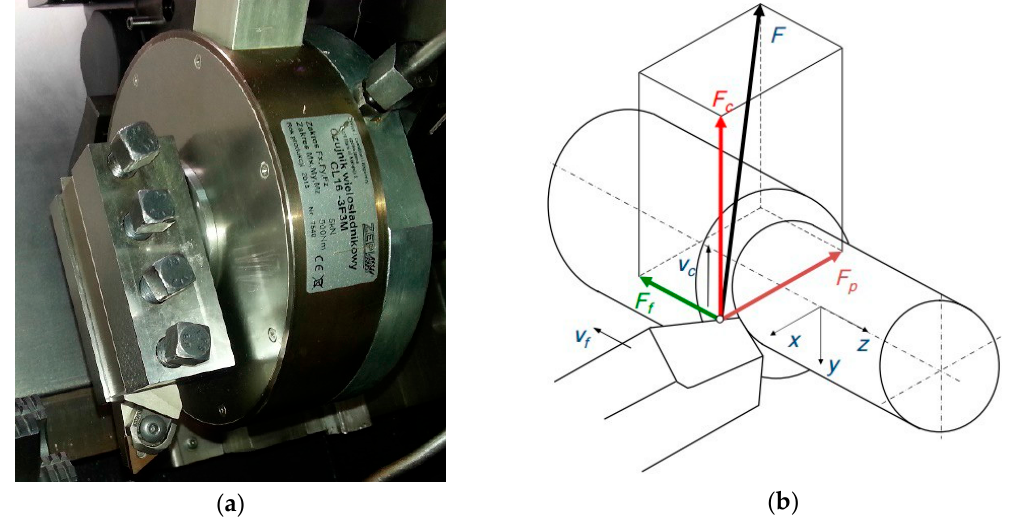
Figure 1. CL16-3F3M device: ( a ) The overall view; ( b ) scheme of the measured forces components.